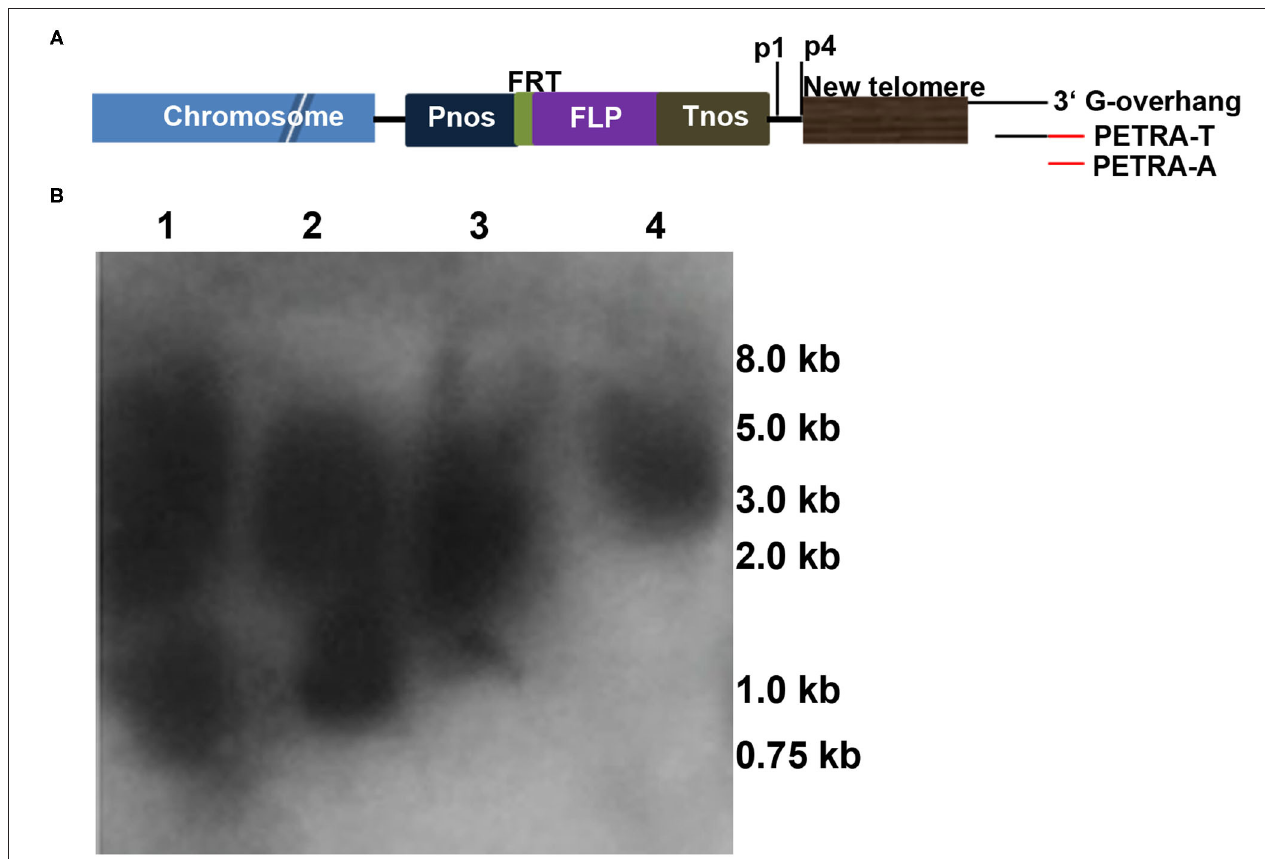
FIGURE 4 | Chromosomal truncations revealed by PETRA. (A) Schematic diagram depicting the PETRA assay. PETRA-T oligonucleotides ( Supplementary Table 1 ) were annealed to the G-rich overhang at the 3 ′ end of the de novo telomeres, and primer extension was performed with DNA polymerase I. Then, the primer extension products were subjected to PCR amplification using the transgene-specific primer p1/p4 ( Supplementary Table 1 ) and the PETRA-T complementary primer PETRA-A ( Supplementary Table 1 ). The resulting PCR products were separated by gel electrophoresis, transferred to membranes and hybridized with the 32 P-labeled pWY96 probe. (B) PETRA reactions with primers p1 and p4 were performed for each of the two transgenes, 86-1-73 and 86-1-75. Lane 1: p1, 86-1-75; lane 2: p4, 86-1-75; lane 3: p1, 86-1-73; lane 4: p4, 86-1-73. M, Trans2K PlusII DNA Marker. Lanes 1–4 show the staggered size